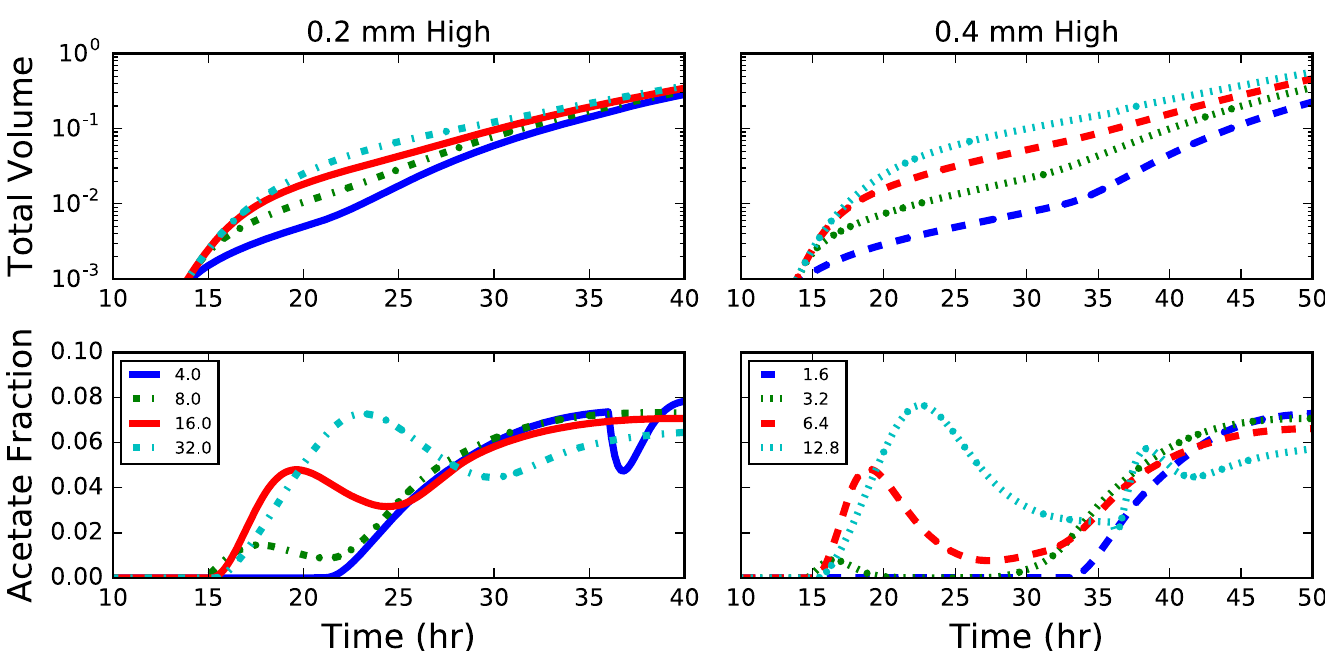
Fig 8. Plateau geometry. Plots of total colony volume (top) and fraction of acetate utilizers (bottom) for coloniesgrown on plateausof agar 0.2 (left) and 0.4 (right) mm in height. The legendindicatesthe aspect ratio (width:height) of the plateauand colors correspondto simulations with the same plateau